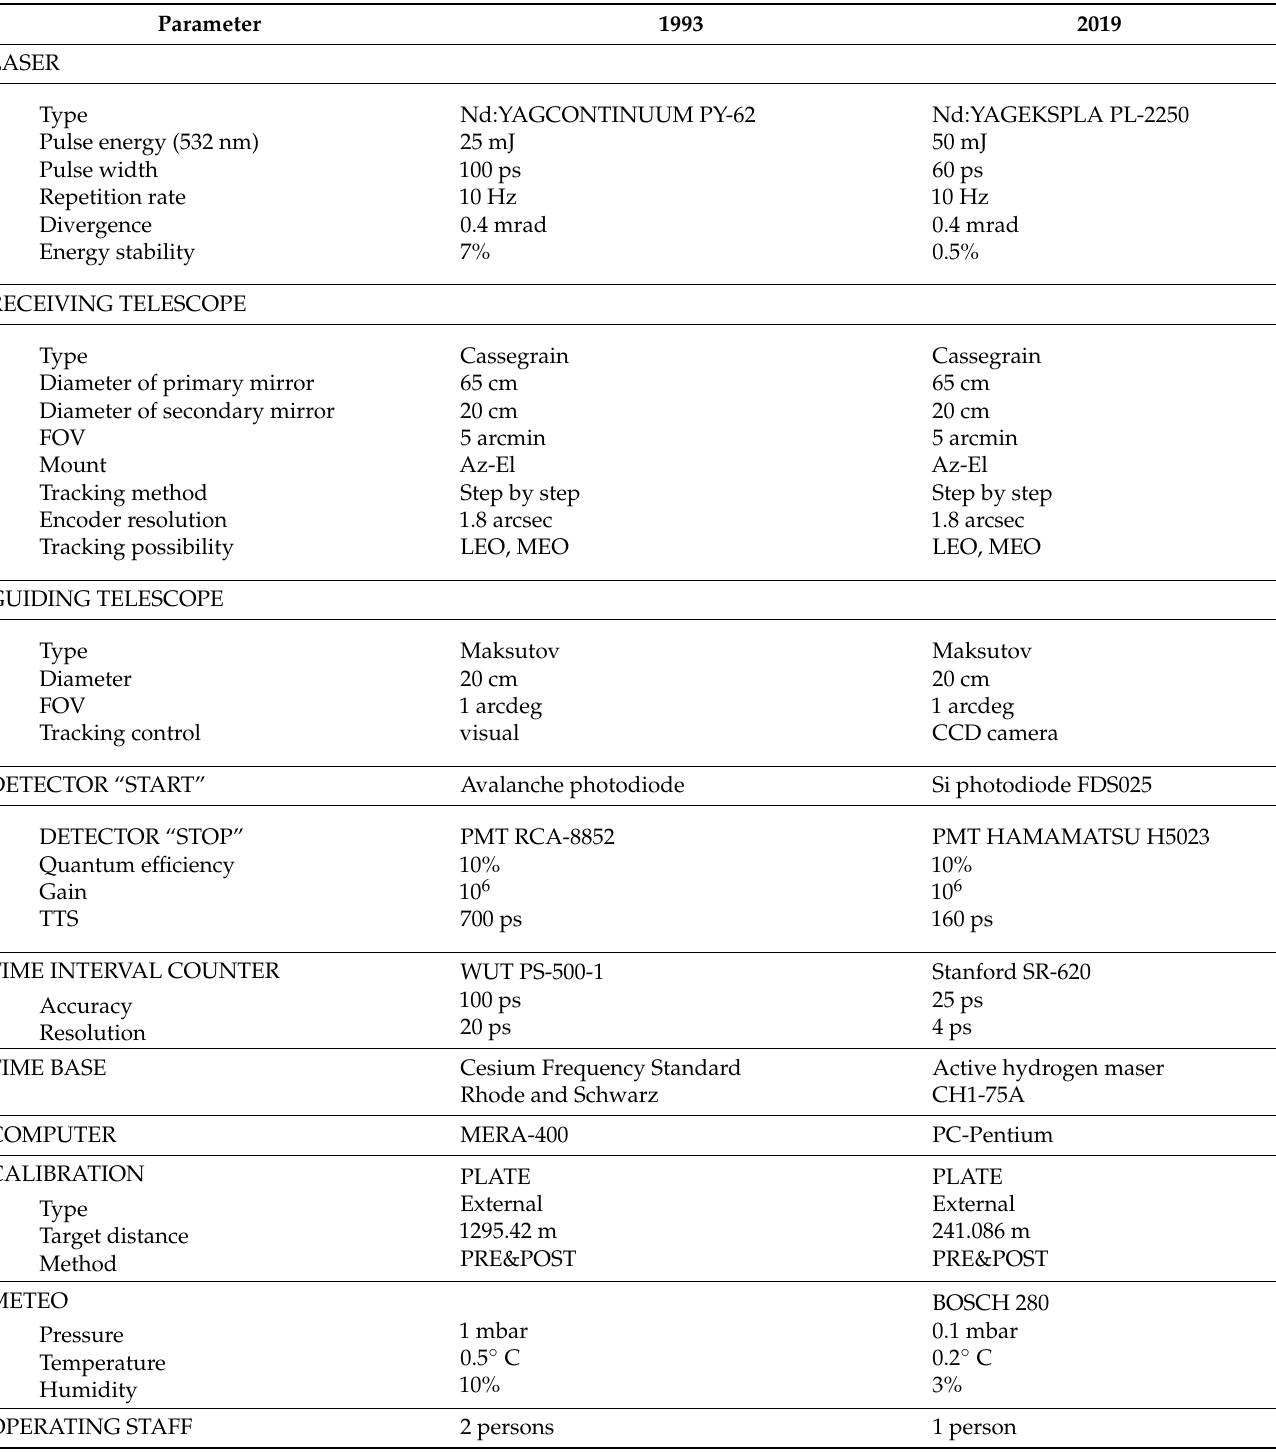
Table 2. Parameters of the Borowiec SLR station in 1993 and